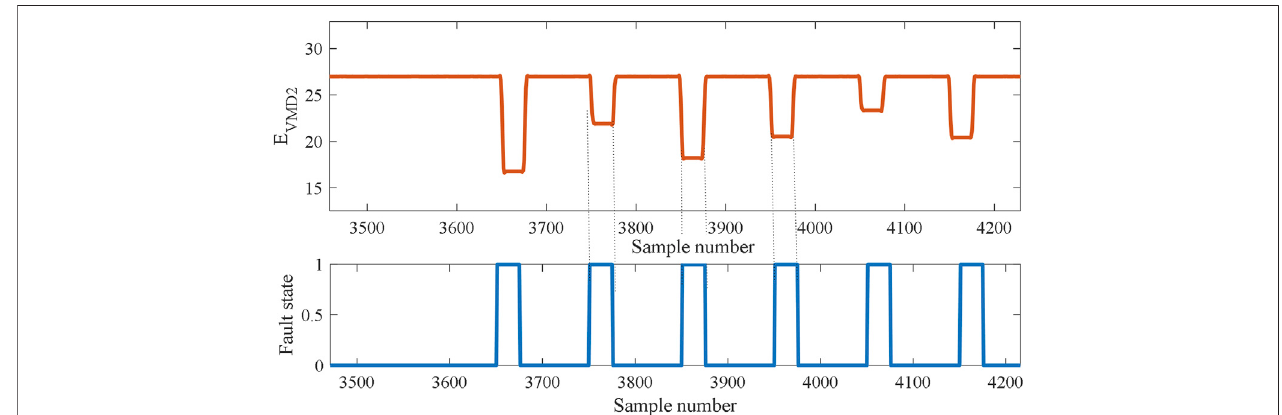
FIGURE 9 | Energy of second IMF of voltage signal serving as input for SVM-based fault detection.